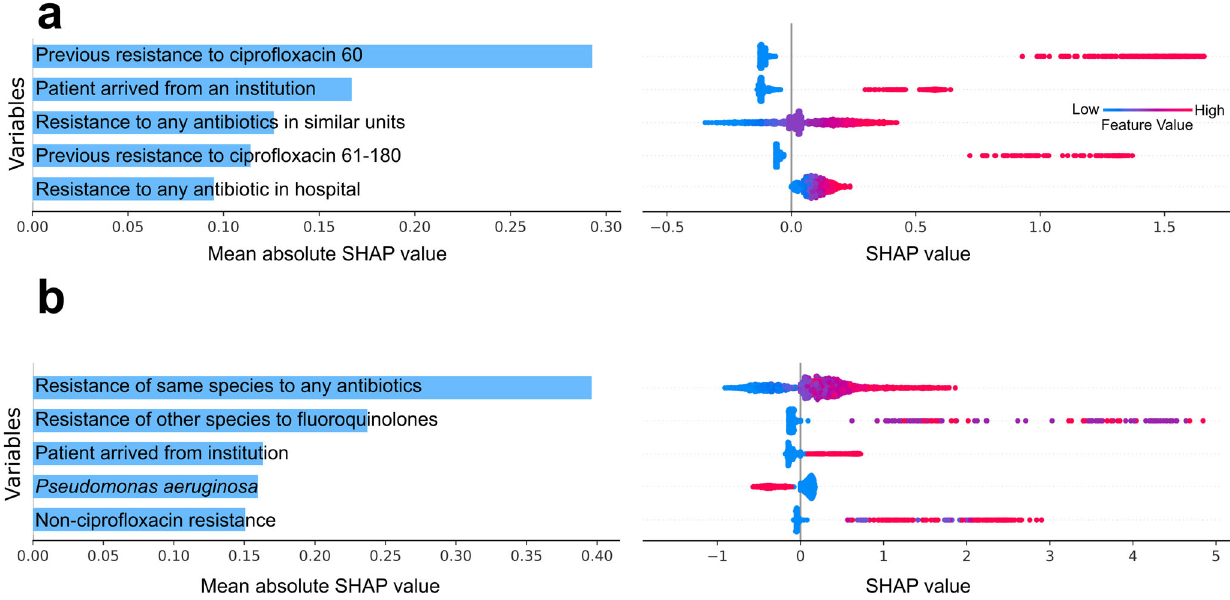
Fig. 3 SHAP values of the ensemble model for the fi ve most in fl uential variables in the agnostic and gnostic datasets. agnostic ( a ), gnostic ( b ). The absolute SHAP values are presented in the left column. A swarm plot is presented in the right column, wherein colors (from blue to red) correspond to variable values (from low to high), whereas the in fl uence of those variables on the log-OR of predictions is given on the x-axis. Previous resistance to cipro fl oxacin 60 — whether the patient had a cipro fl oxacin resistant infection in the past 60 days. Resistance to any antibiotic in similar units - past 30 days moving average of resistance to any antibiotic in the same type of units (orthopedic, gynecology etc.). Previous resistance to cipro fl oxacin 61-180 — whether the patient had a cipro fl oxacin resistant infection in the 61-180 days prior to drawing the culture. Resistance to any antibiotics in hospital — past 30 days moving average of resistance to any antibiotic in the hospital. Resistance of the same bacterial species to any antibiotic - past 30 days moving average across the hospital. Resistance of other species to fl uoroquinolones - the past 60 days, in the same patient. Non-cipro fl oxacin resistance — number of non-cipro fl oxacin antibiotics that the same bacterial species was resistant to in the last 60 days, in the same patient.